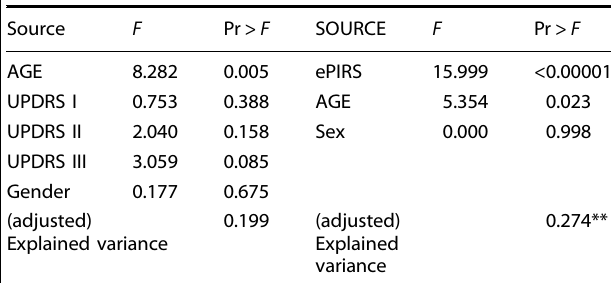
Table 5. Relative relationship of ePI to PIGD